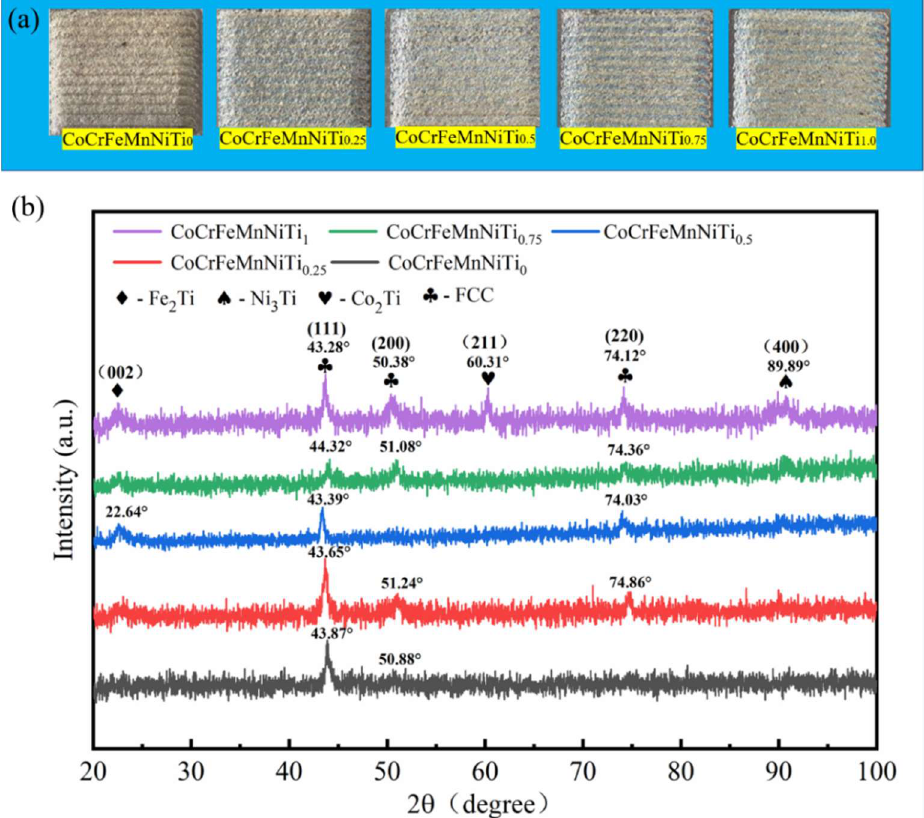
Figure 3. ( a ) Surface topography of CoCrFeMnNiTi x coatings and ( b ) XRD pattern of CoCrFeMnNiTi x coatings.